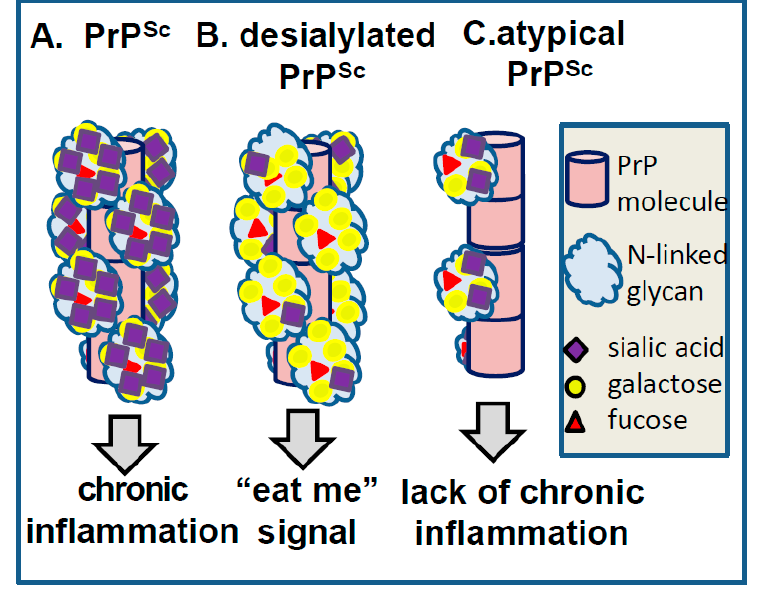
Figure 6. Schematic representation of the hypothesis proposing that carbohydrate epitopes on PrP Sc surface determine response of glia. A. High density of glycans with terminal sialylation leads to chronic neuroinflammation. B. Desialylation of PrP Sc that results in a high density of exposed galactose triggers “eat me” signal in glia. C. Atypical PrP Sc has low density of glycosylation and sialylation, similar to those of sialoglycocalyx. Atypical PrP Sc does not trigger “eat me” signal or chronic neuroinflammation.